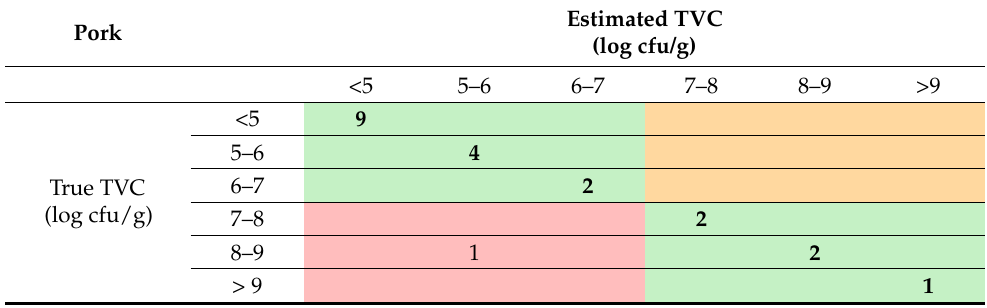
Table 2. Confusion matrix of classification regarding the state of freshness of pork samples. The background color represents the extent of the severity of a possible